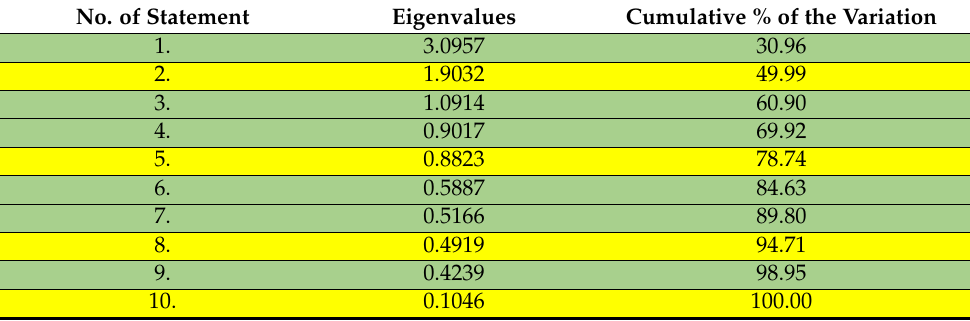
Table 2. Equity and cumulative percentage of variability.